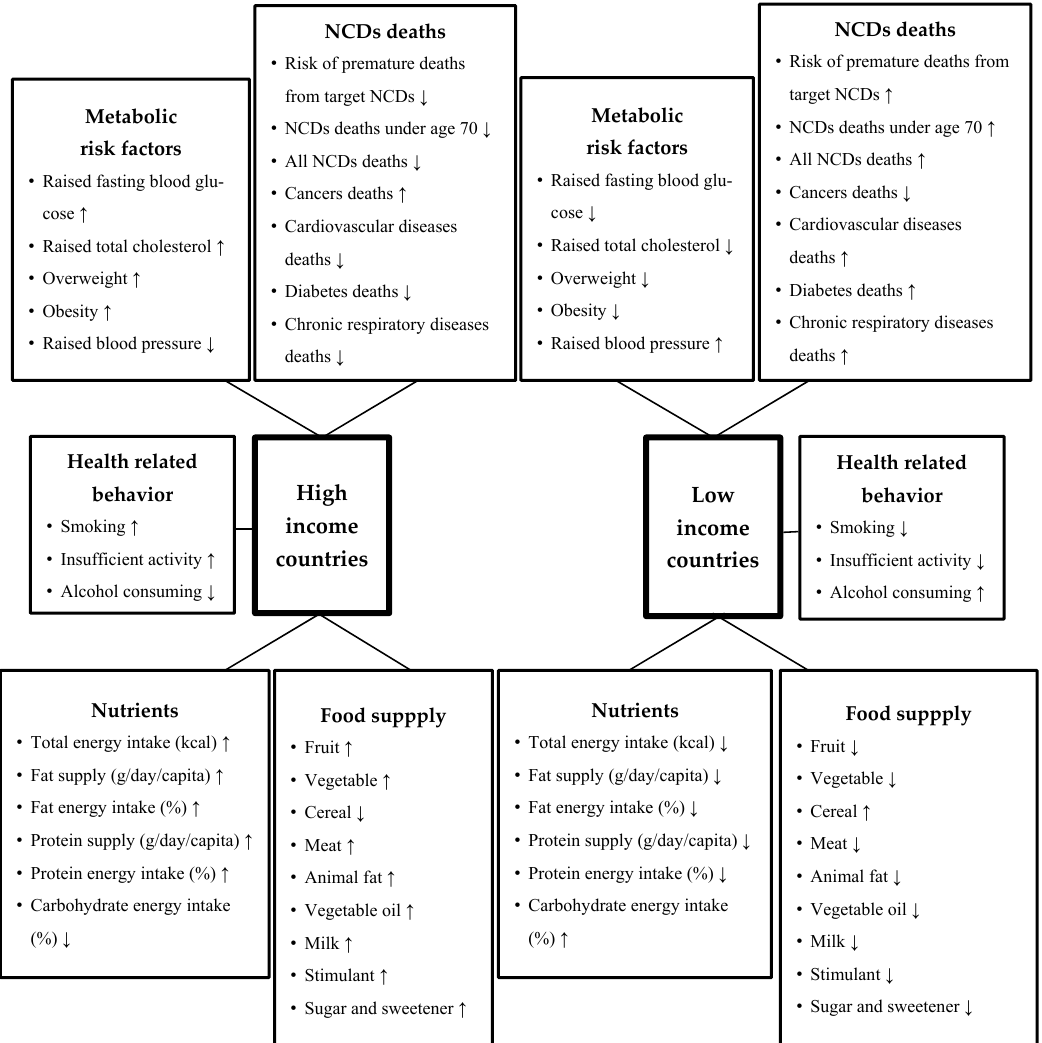
Figure 5. Relative comparison of high- and low-income countries in metabolic risk factors, mortality, and health-related behavior, energy intake, and food supply.